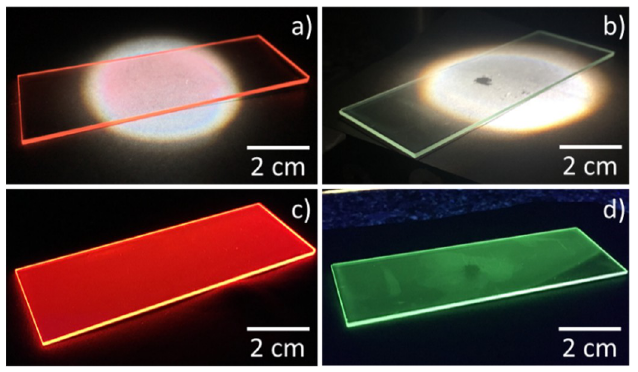
Figure 3. Photographs of the LSCs based on ( a , c ) PMMA-Eu and ( b , d ) PMMA-Tb under AM1.5G (top) and UV radiation at 365 nm (bottom).